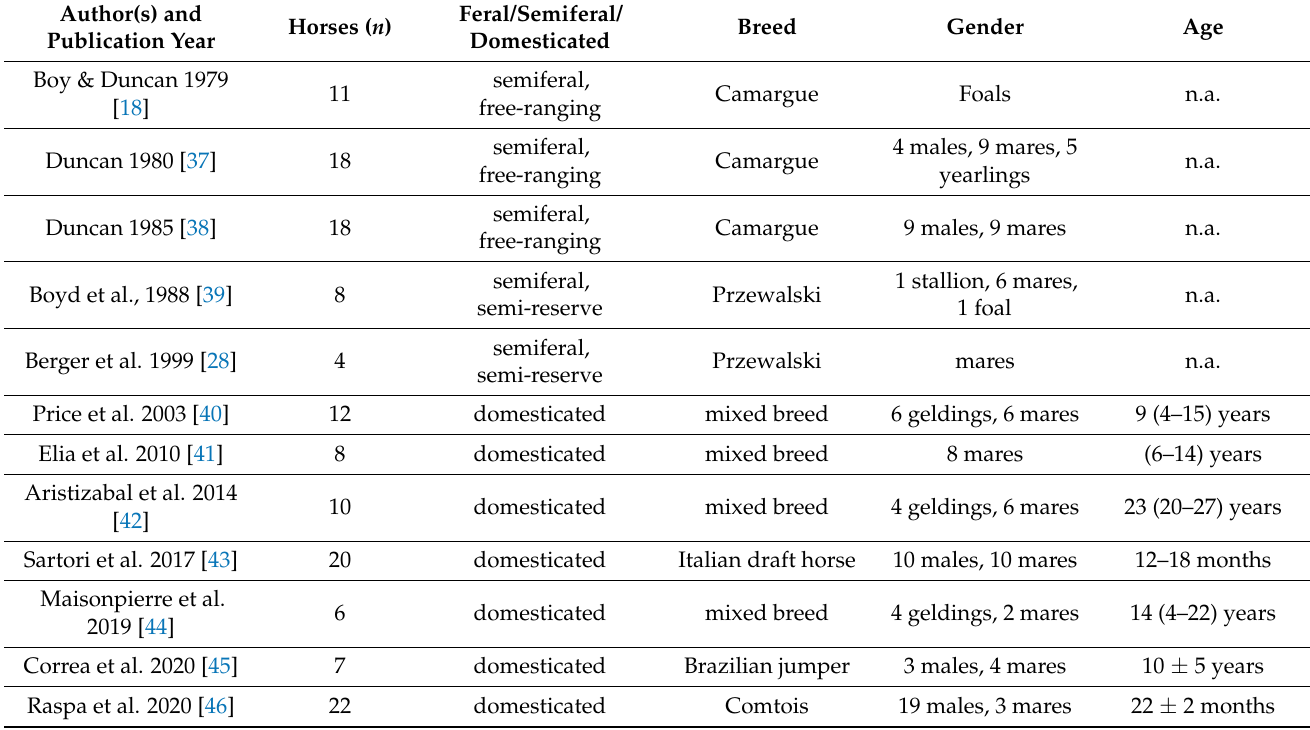
Table 2. Signalment of horses included in the study. Depending on the data available in the respective papers, ages are provided as range, median (plus range), or mean ± standard deviation. Similarly, the gender is detailed depending on the information provided in the